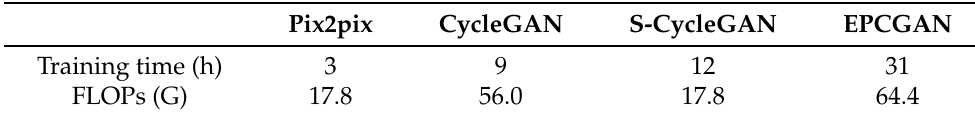
Figure 7. A comparison of the parameters of different SAR-to-optical methods. Table 3. Training times and FLOPs of different methods.